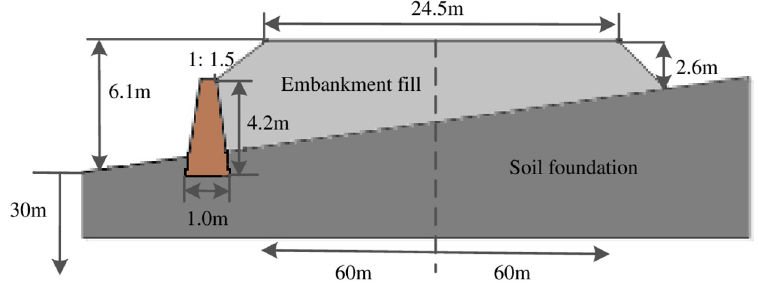
Fig 2. Finite difference model of the embankment fill-soil foundation-retaining wall